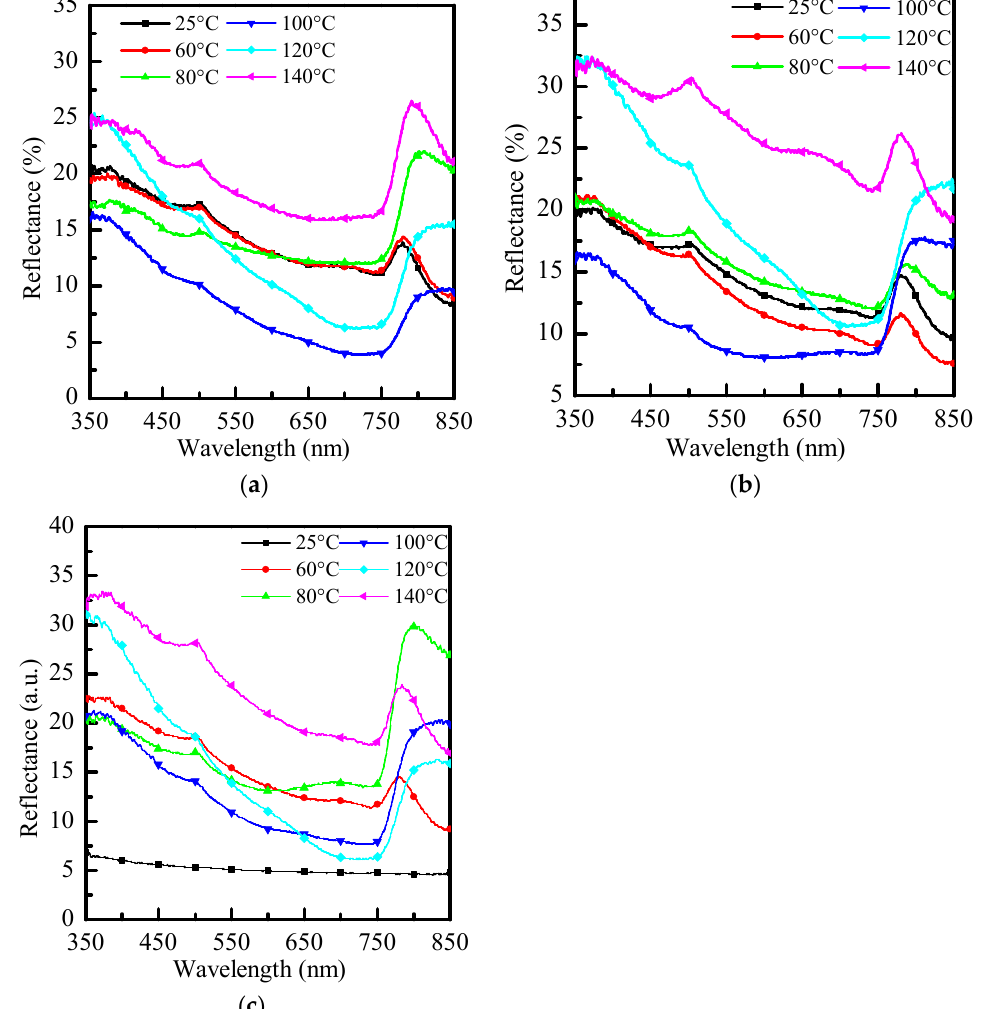
Figure 4. Reflectance graphs of ( a ) PhMe, ( b ) PhCl, and ( c ) ODCB at different re-annealing temperatures, respectively.